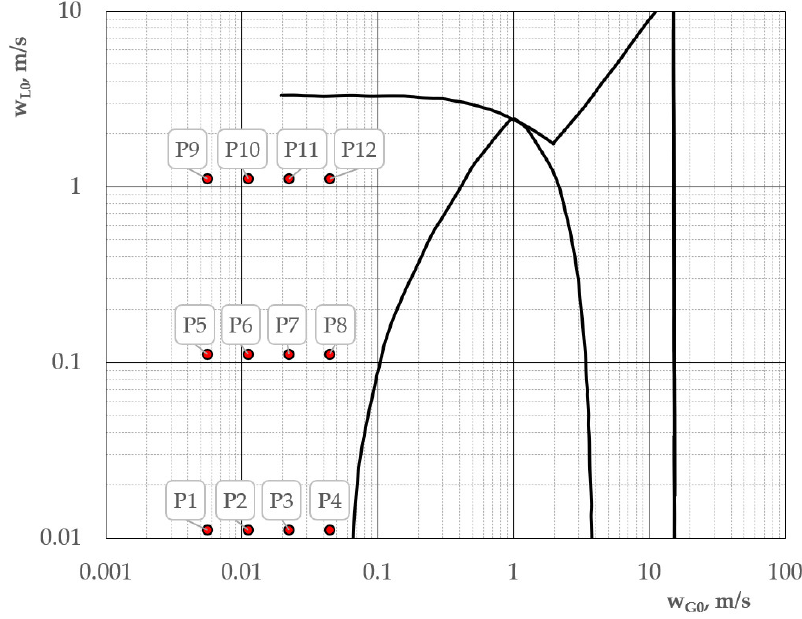
Figure 6. Two-phase flow map according to Titel for vertical pipe with the research area shown (red dots).